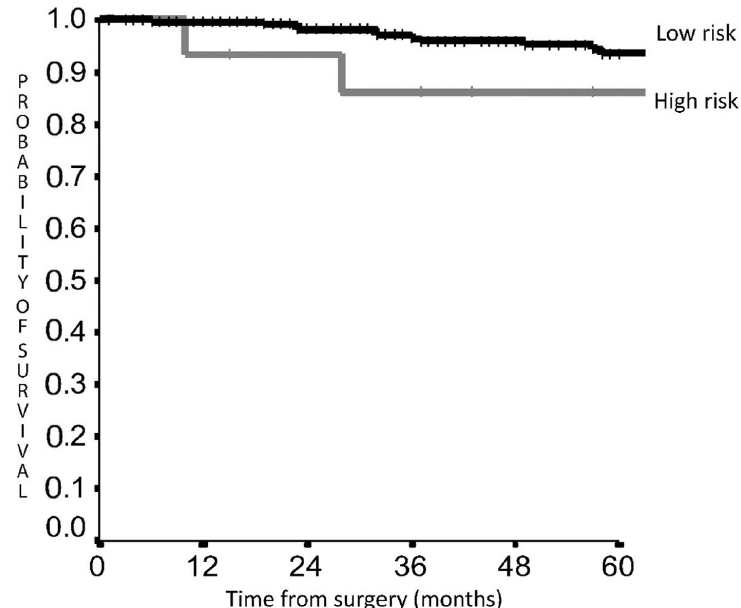
Figure 3. Overall survival according to score risk classes.